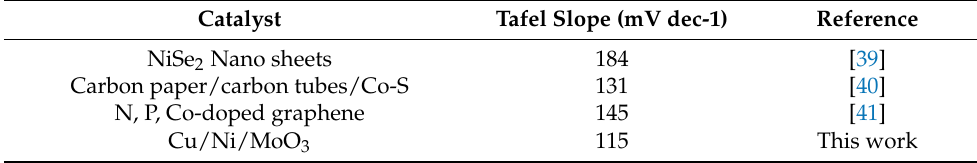
Figure 8. Electrical characterization of Cu-Ni. Table 1. Comparison of the HER performance of Cu-Ni with other